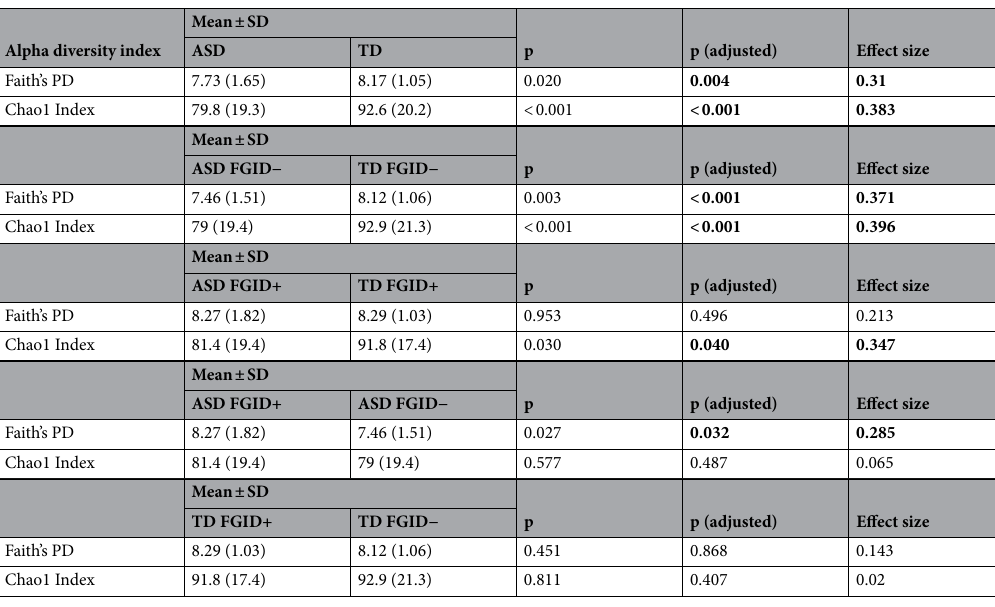
Table 2. Summary of Mann–Whitney U tests on alpha diversity indices across ASD and TD groups. Significant values are in bold. ASD: Autism Spectrum Disorder, TD: Typically Developing; Faith’s PD: Faith’s